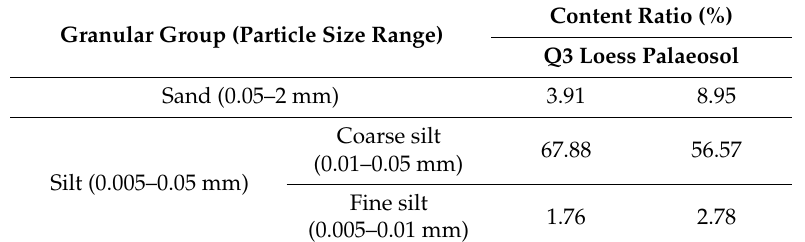
Figure 5. The devices for the basic hydraulic properties: ( a ) the Ksat device; ( b ) the HYPROP device. Table 1. Grain size distribution.